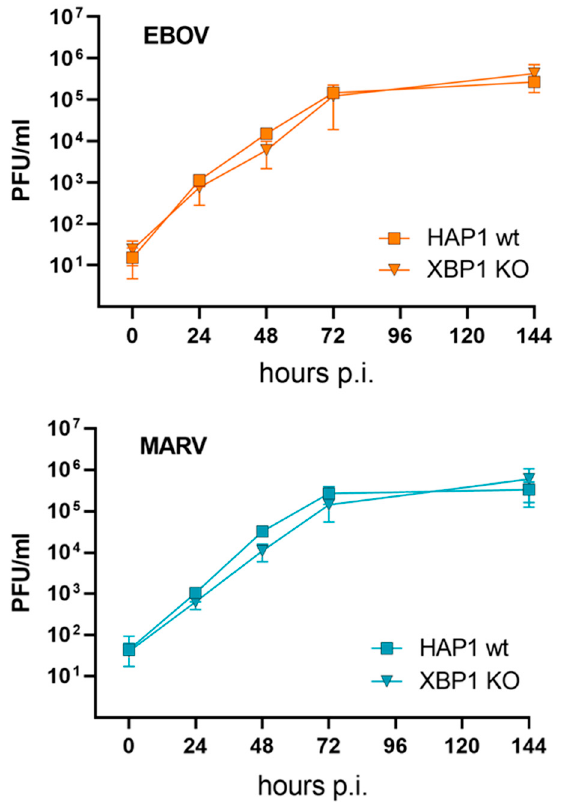
Figure 6. XBP1 KO does not affect filovirus propagation. HAP1 wildtype (wt) or KO cell were infected with MARV or EBOV (MOI = 1). At the indicated time points, cell supernatant was collected. Viral titers were determined using plaque-assay. N = 4.